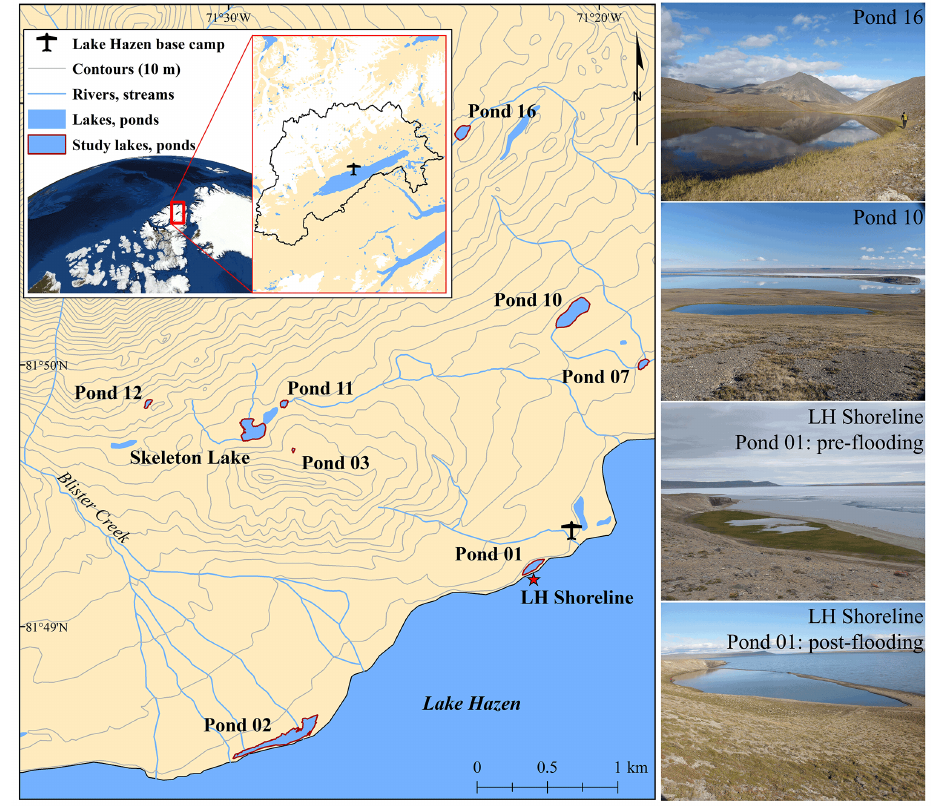
Figure 1. Map of the Lake Hazen base camp in Quttinirpaaq National Park, Nunavut, Canada. Ponds and lakes investigated in this study are indicated on the map, and selected sites are shown in photographs. Inset shows the general locators of the Lake Hazen